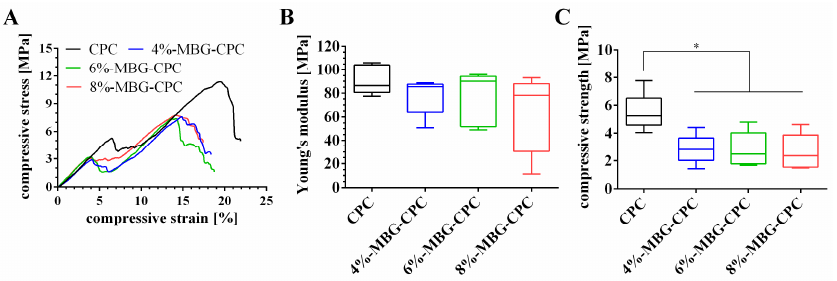
Figure 5. Mechanical properties of CPC, 4%-MBG-CPC, 6%-MBG-CPC and 8%-MBG-CPC sca ff olds. ( A ) Representative compressive stress-strain curves. ( B ) Young’s modulus and ( C ) compressive strength determined from the curves (* p < 0.05, mean ± standard deviation, n =